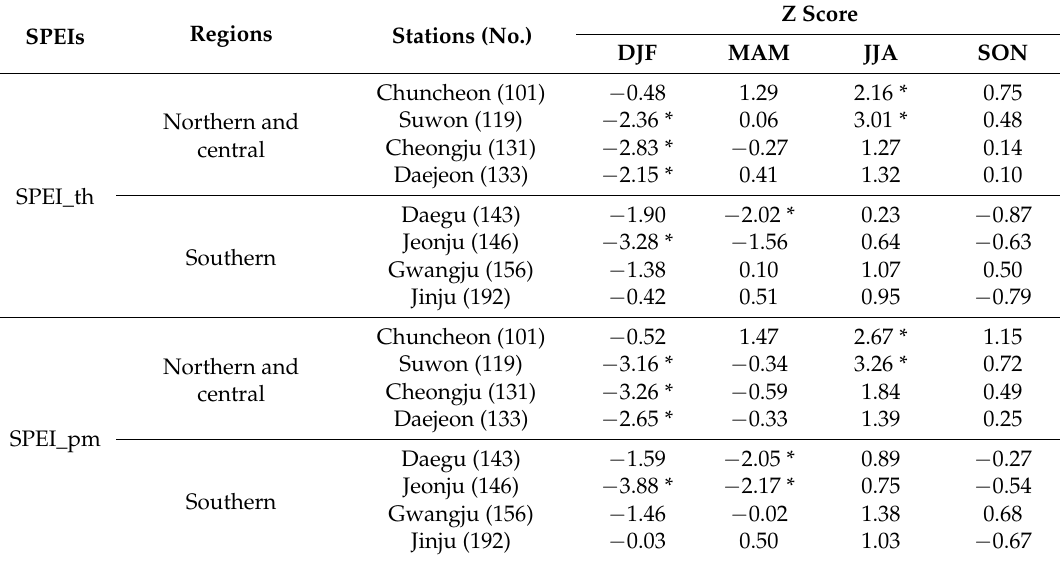
Table 5. The results of the Mann–Kendall (MK) trend test for 3-month SPEI_th and SPEI_pm.